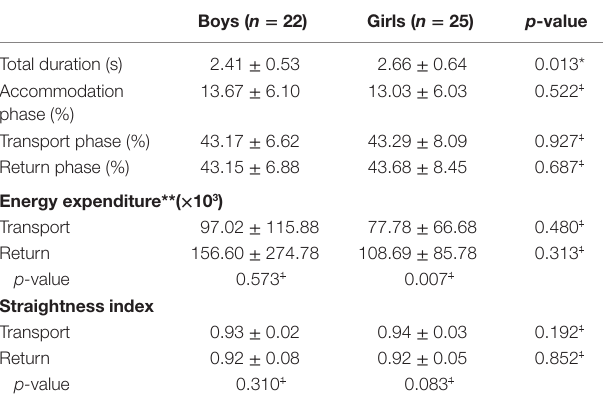
TABle 1 | Spatial-temporal parameters for boys and girls.